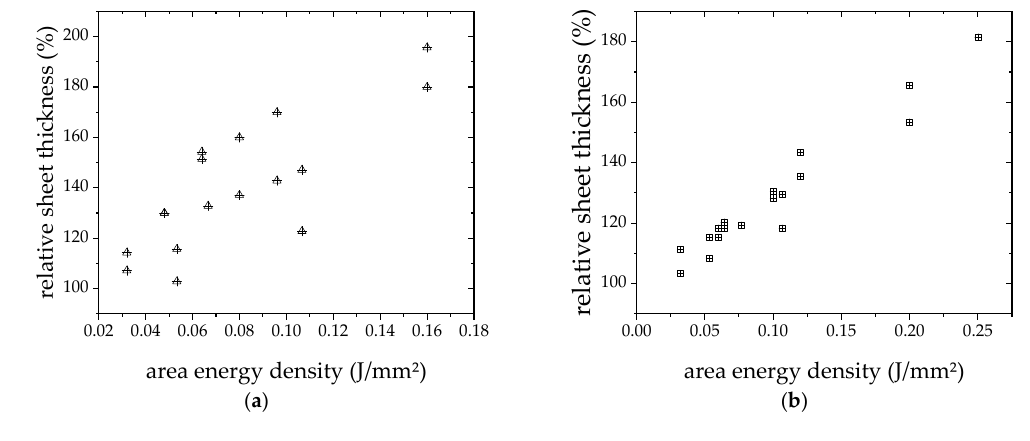
Figure 6. Sheet thickness vs. E sq . ( a ) p-type; ( b ) n-type.